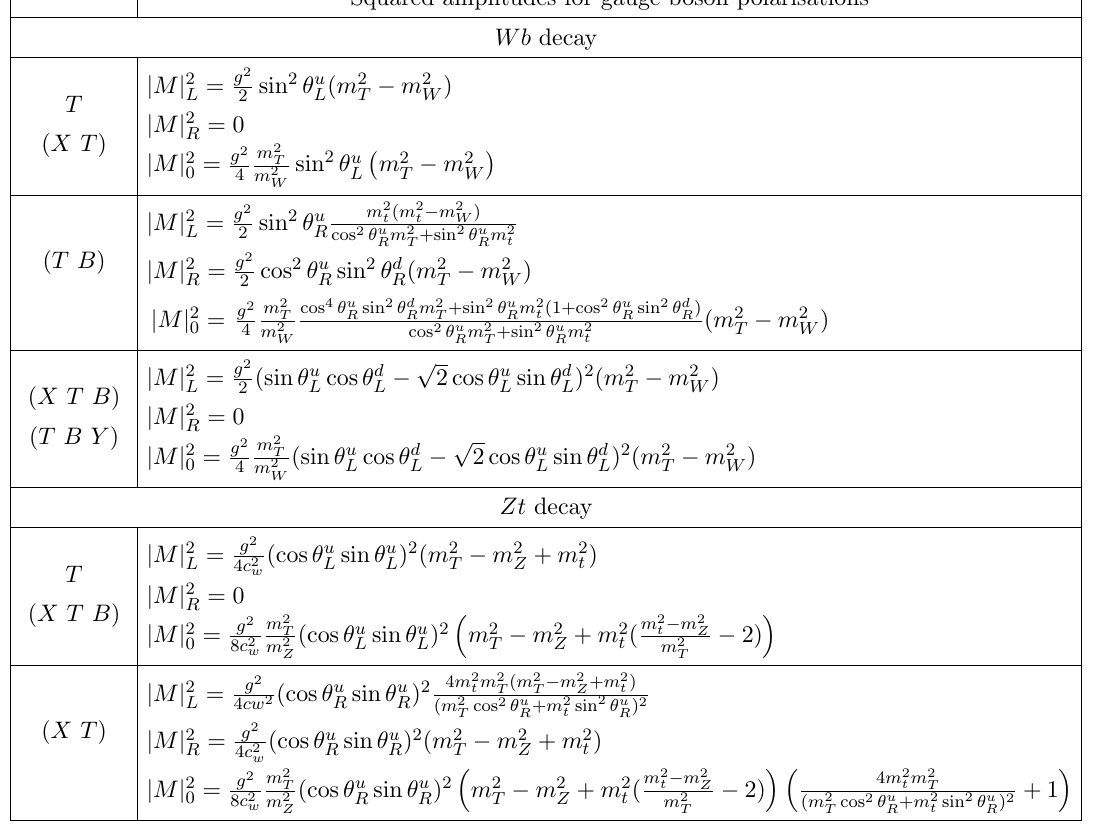
Table 3 . Contribution from di(cid:11)erent W and Z bosons polarisations to the squared amplitude for the processes T ! Wb an T ! Zt in the limit m b ! 0. For the Z boson, the ( T B ) doublet expressions can be obtained from the T and ( X T B ) ones, exchanging the left and right components; analogously, the ( T B Y ) triplet expressions can be obtained from the ( X T ) doublet with the same